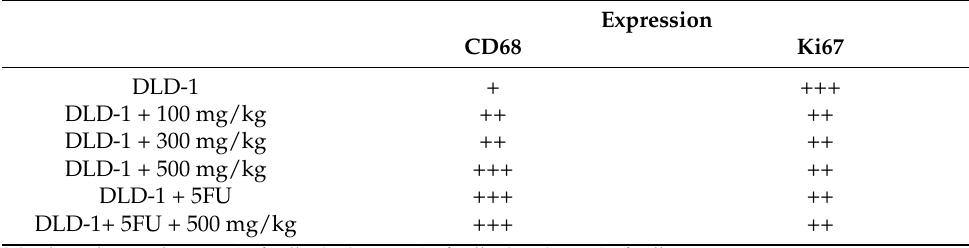
Table 3. Expression of CD68 and Ki67 in the DLD-1 tumor.